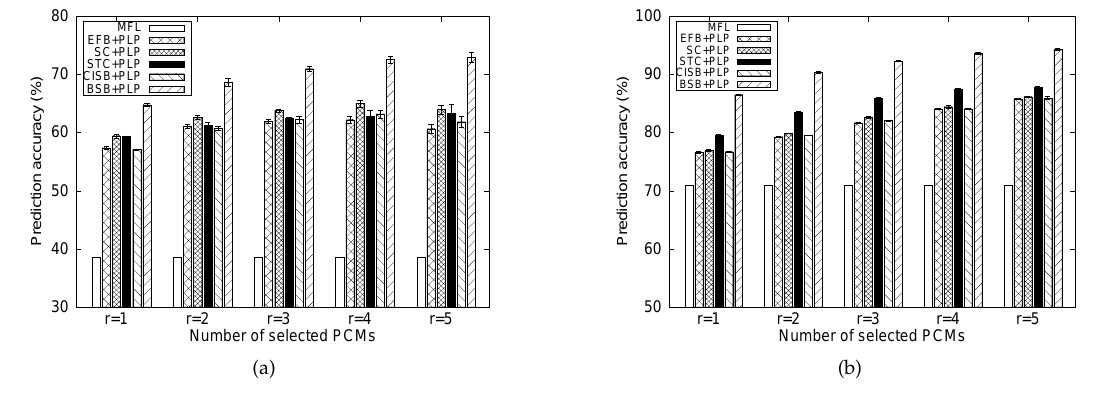
Figure 7. Effects of the number of PCMs on the performance of the prediction model in case of ( a ) the MIT dataset and ( b ) Dartmouth